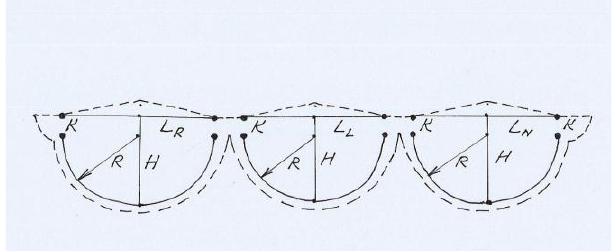
Fig. 2 - Marking of the calculated parameters of the aortic valve in the pericardium (LR, LL and LN are the lengths of coapting edge of right, left and noncoronary cusps, respectively; H is the cusps height; R is the annular margin line radius and K is the commissural